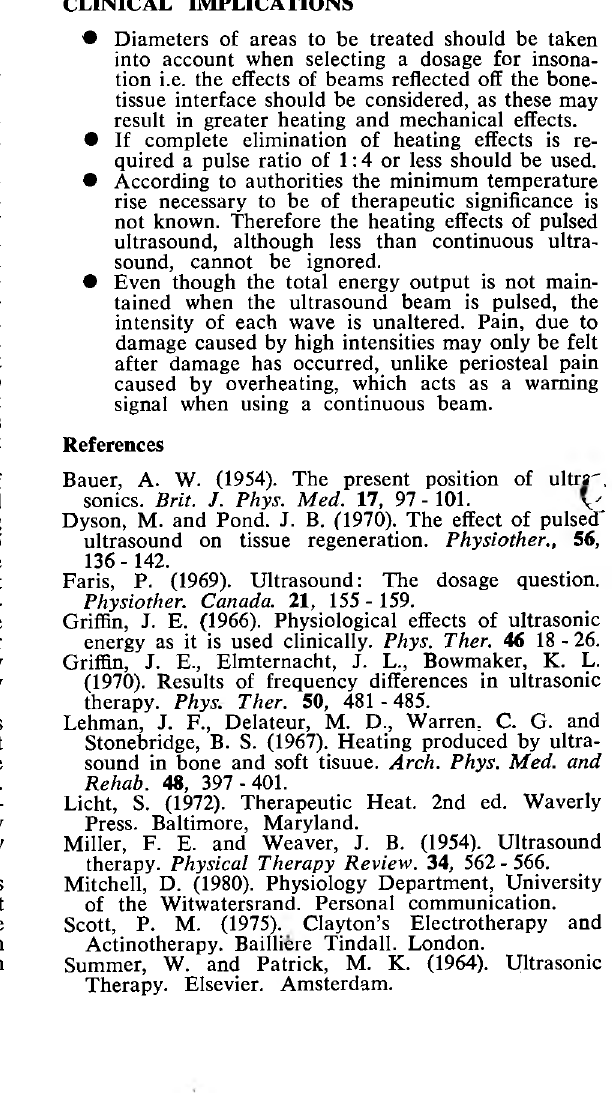
GRAPH TO ILLUSTRATE THE COMPARISON OF AVERAGE PEAK TEMPERATURE CHANGES PRODUCED BY CONTINUOUS ULTRASOUND AND PULSED ULTRASOUND AT PULSE RATIOS OF 1:1 and